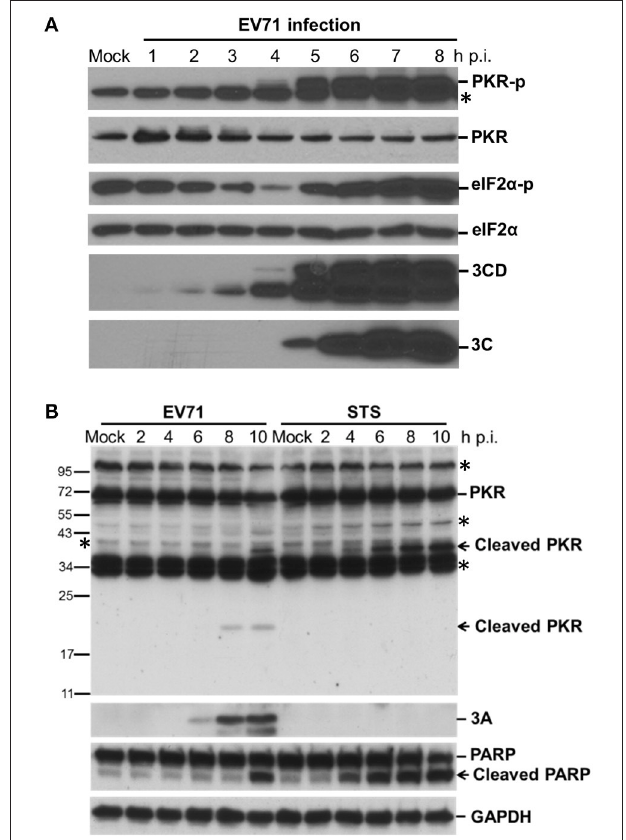
FIGURE 1 | EV-A71 infection results in the phosphorylation and cleavage of PKR. (A) Time course of cellular protein phosphorylation and protein levels after EV-A71 infection. RD cells were infected with EV-A71 at an m.o.i. of 10. At the indicated times post-infection, cell extracts were collected. The total cellular protein in the extracts was quantified, and equivalent amounts from each sample were subjected to western blot analysis for the detection of cellular PKR, phosphorylated-PKR (PKR-p), eIF2 α , and phosphorylated eIF2 α (eIF2 α -p), as well as the expression of viral 3CD and 3C proteins. eIF2 α expression was detected as a protein loading control. An asterisk marks non-specific bands. A representative result from three independent experiments is shown. (B) Cleavage of PKR after EV-A71 infection. RD cells were infected with EV-A71 at an m.o.i. of 10 or treated with STS for 2, 4, 6, 8, and 10 h. Cell extracts were collected at the indicated times for immunoblotting analysis to detect the cellular PKR and viral 3A protein levels. PARP cleavage was examined as an apoptosis marker. GAPDH expression was detected as a protein loading control. Asterisks indicate non-specific bands. A representative result from at least three reproducible experiments is